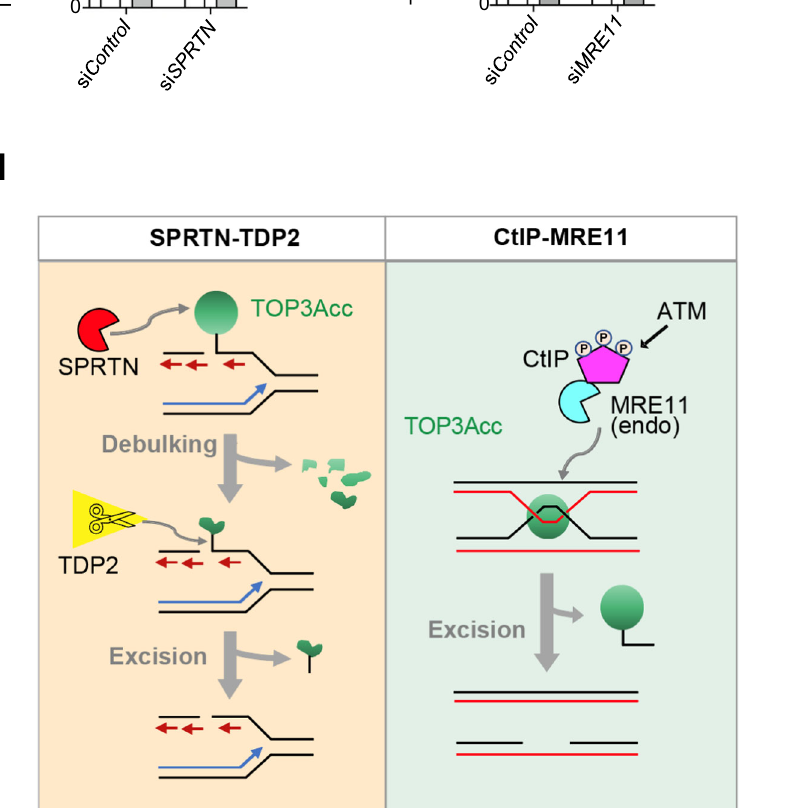
(si Control vs si SPRTN : G2/M-phase), ns Adjusted p -value=0.0903 (si Control